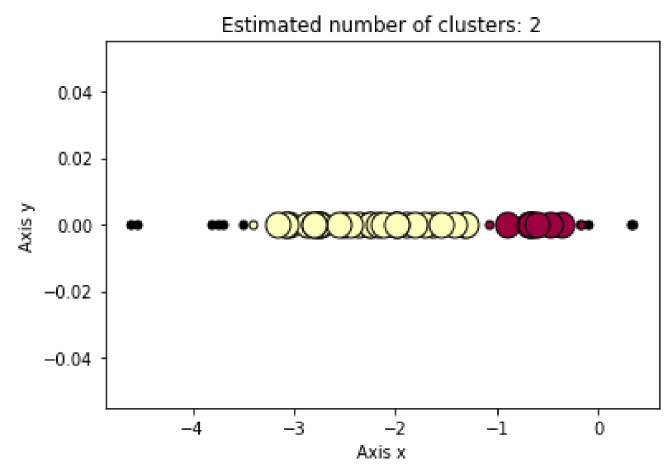
Figure 5. Distribution of predicted DBSCAN clustering result using LD1 as input.